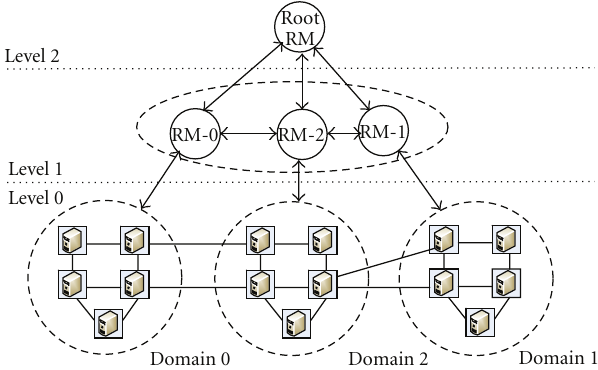
Figure 1: Two levels of hierarchical grid